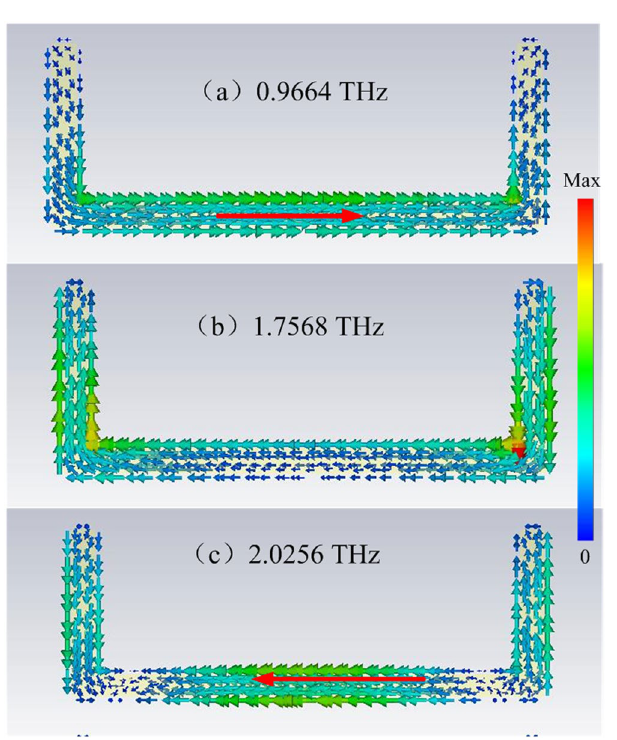
Figure 3. Distributions of current surface of the whole structure with coupled strips at ( a ) 0.996, ( b ) 1.7568, ( c ) and 2.0256